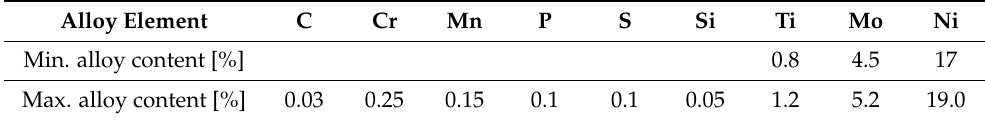
Table 1. Chemical Formulation of Maraging Steel M300 [35]. Alloy Element